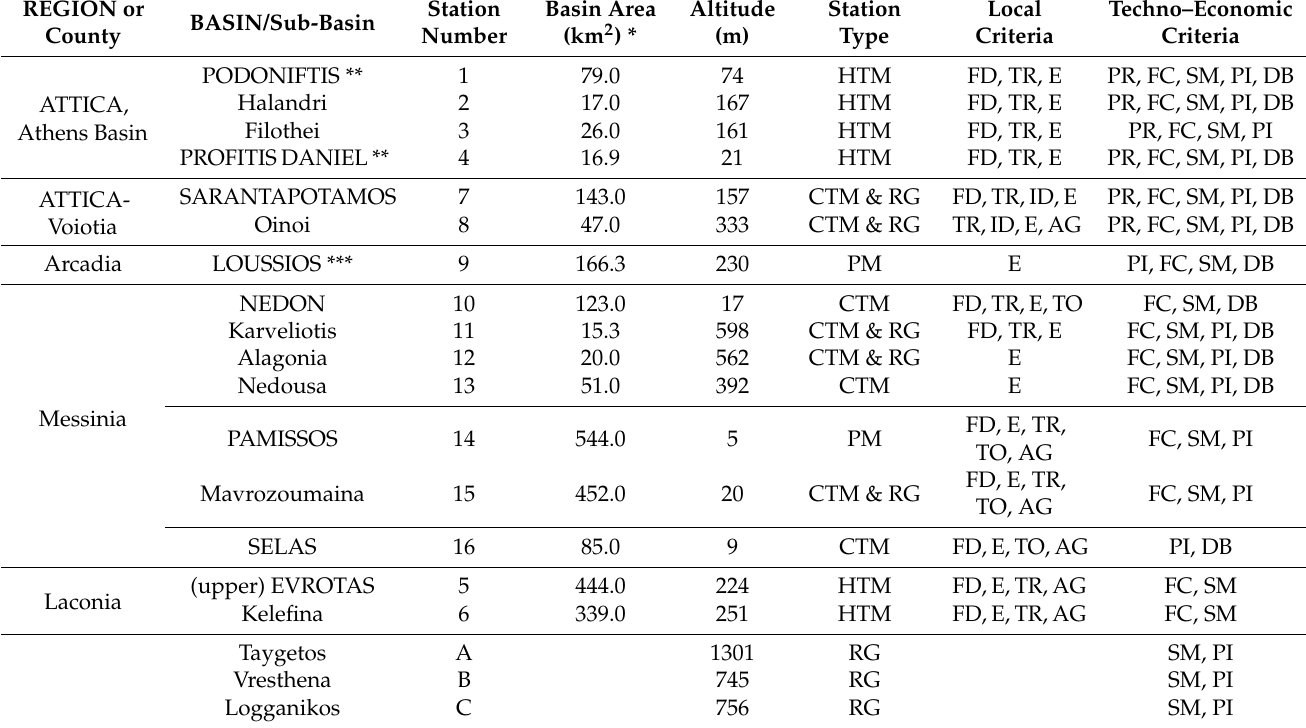
Table 1. Stations: home-made telemetric (HTM), commercial telemetric (CTM), piezometric (PM)